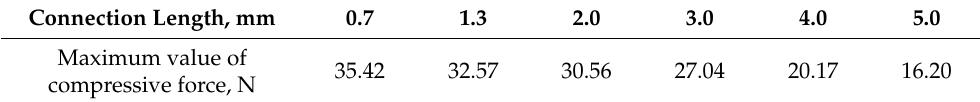
Table 1. Dependence of the maximum value of the compressive force on the connection length.